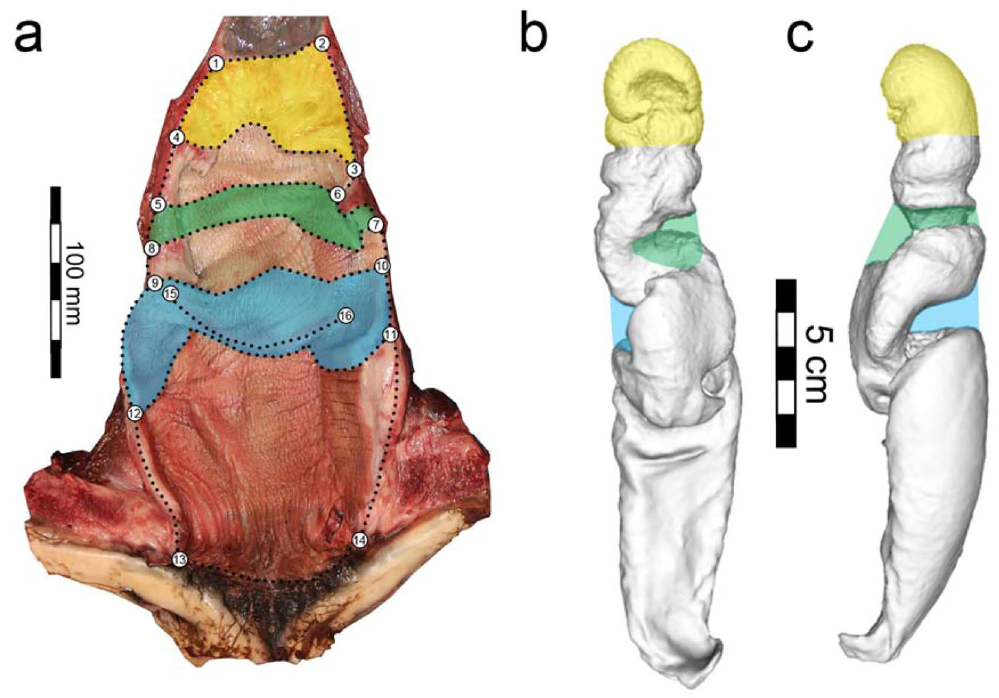
Figure 1. ( a ) Landmarks (numbered) and semi-landmark curves (black dots) of a representative adult harbor porpoise vagina with her ventral side exposed (dorsal recumbency). Semi-landmark curves were placed to capture the cervix (yellow), first large cranial fold (green), and major caudal fold (blue). Scale = 100 mm. 3D model of the silicon mold of the vaginal lumen depicted on the ( b ) ventral side, and ( c ) left lateral side (ID: C-434). Scale = 5